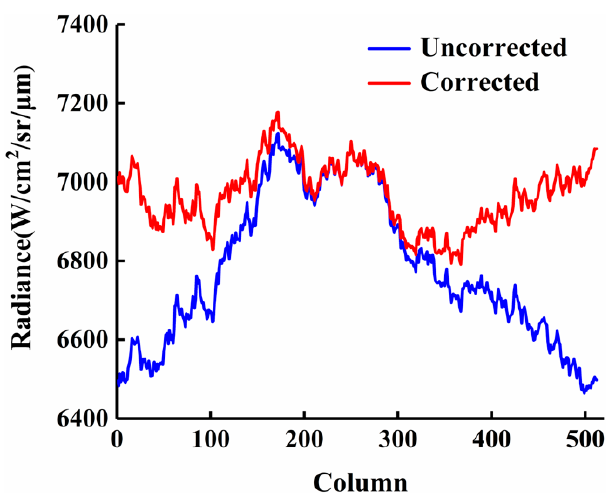
Figure 5. Comparison of radiance before and after correction for radiation attenuation difference.